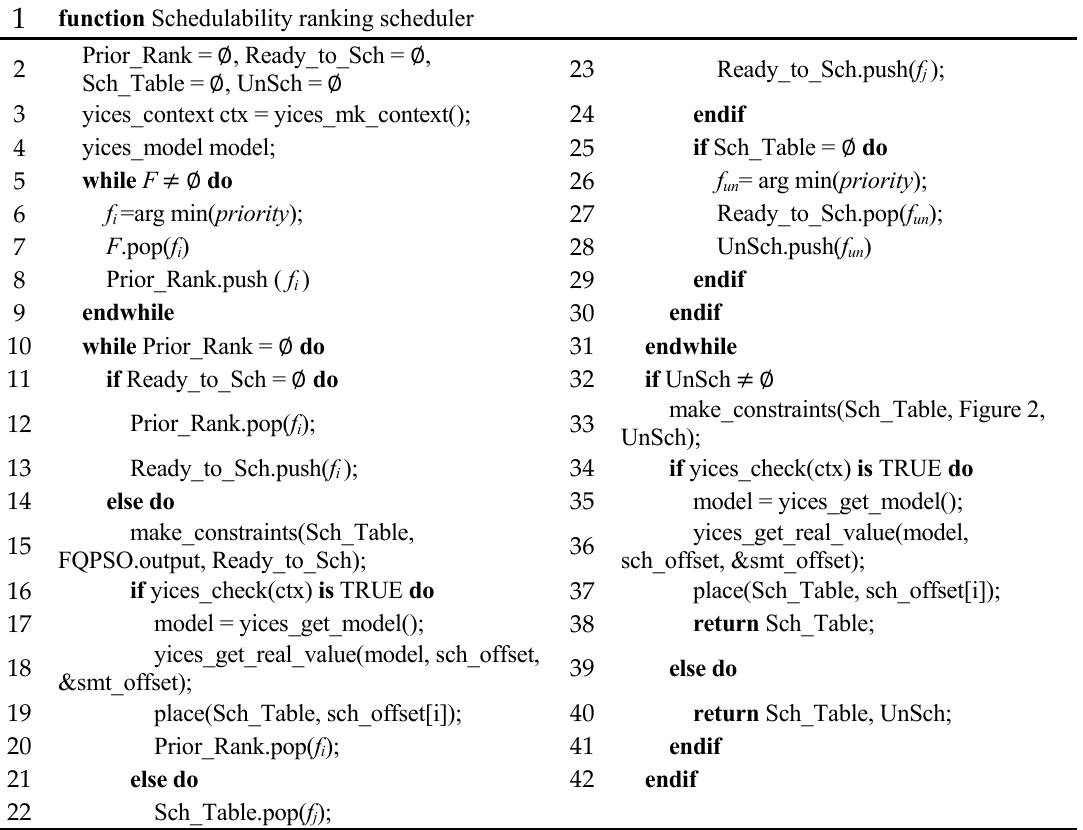
Figure 4. The algorithm of an incremental Satisfiability Modulo Theories (SMT) scheduler.